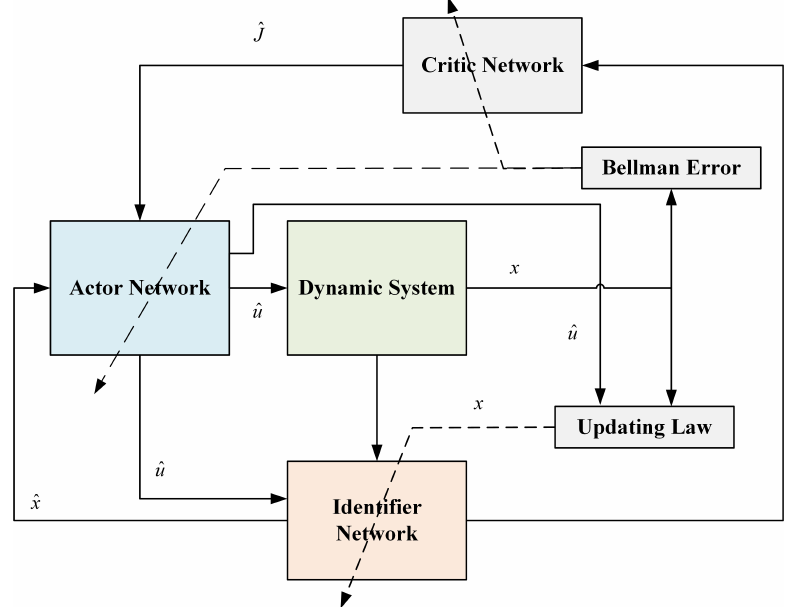
Figure 4. The basic framework of actor-critic-identifier